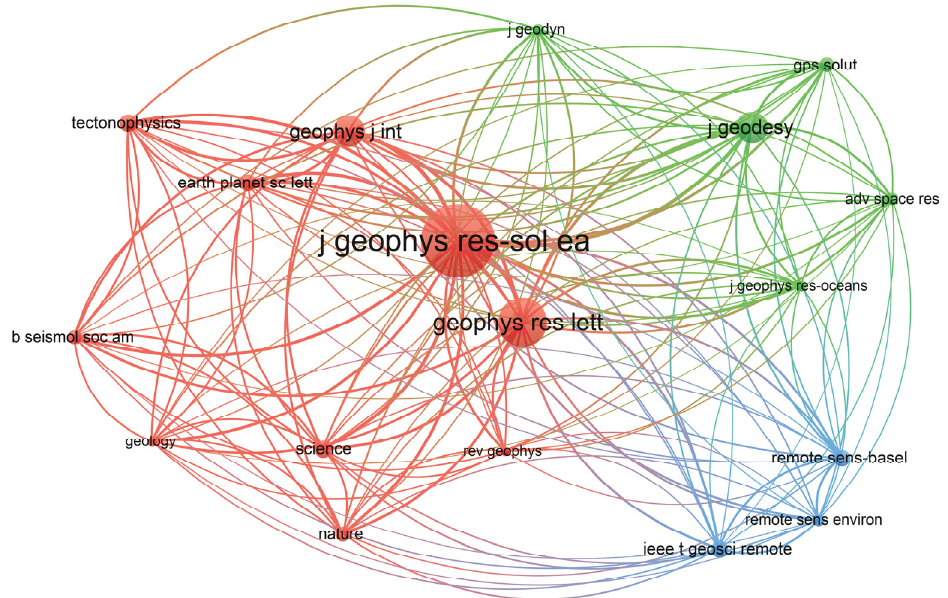
Figure 3. Network of the scientific journals displayed in Figure 1 as a function of the co-citation within these selected journals. We set the limit of the connections threshold in order to present only the 18 highest ranked results.